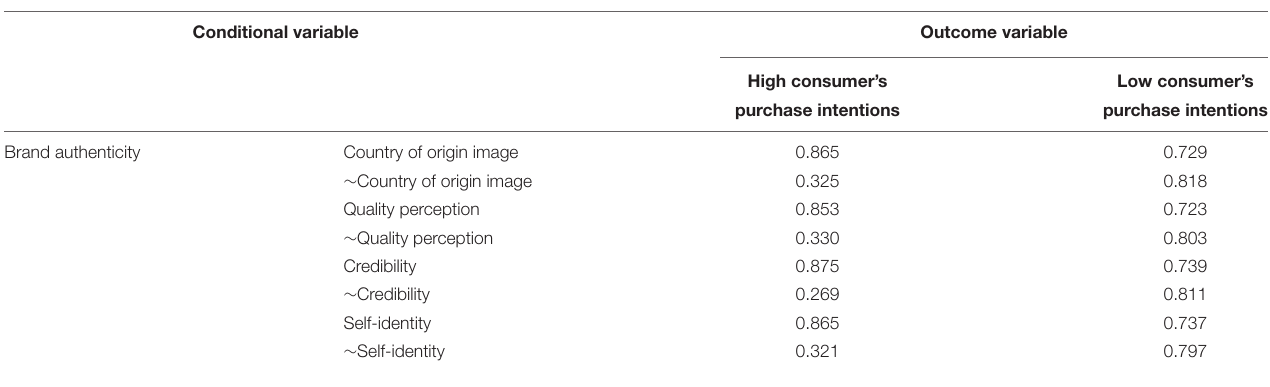
TABLE 5 | Necessity analysis of antecedent